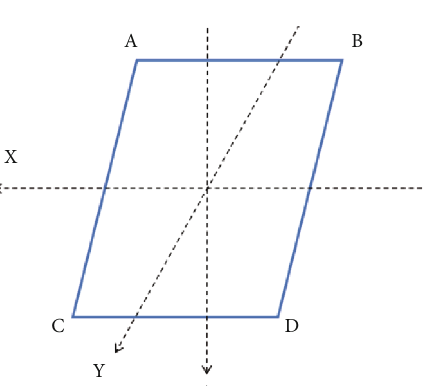
Figure 5: Correspondence between relative coordinate system and absolute coordinate